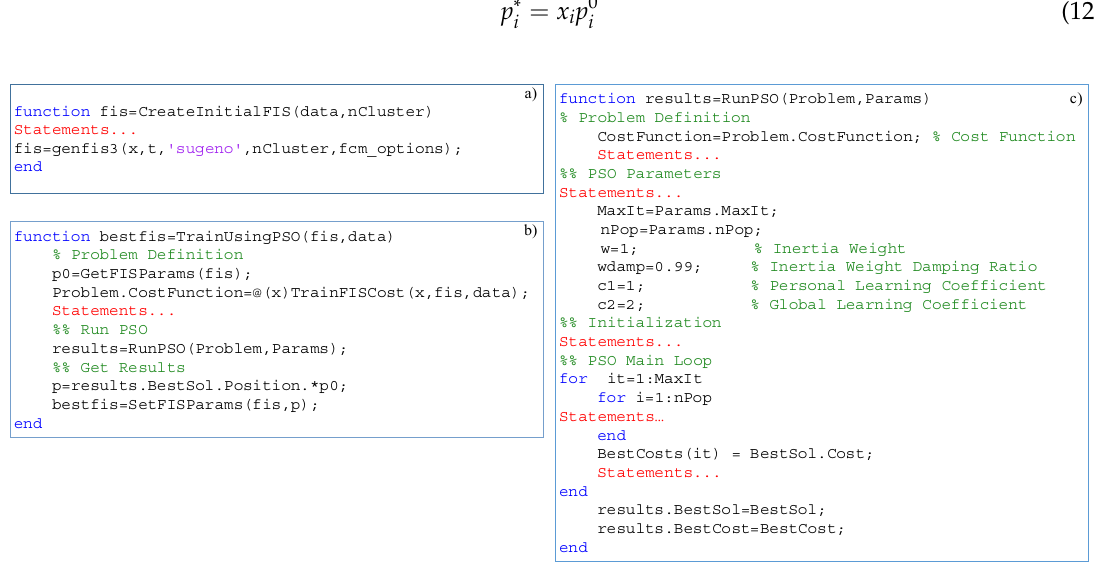
Figure 11. ( a ) creating an initial fuzzy inference system, ( b ) the function of the particle swarm optimization algorithm (PSO) algorithm for training the ANFIS, and ( c ) PSO structure.